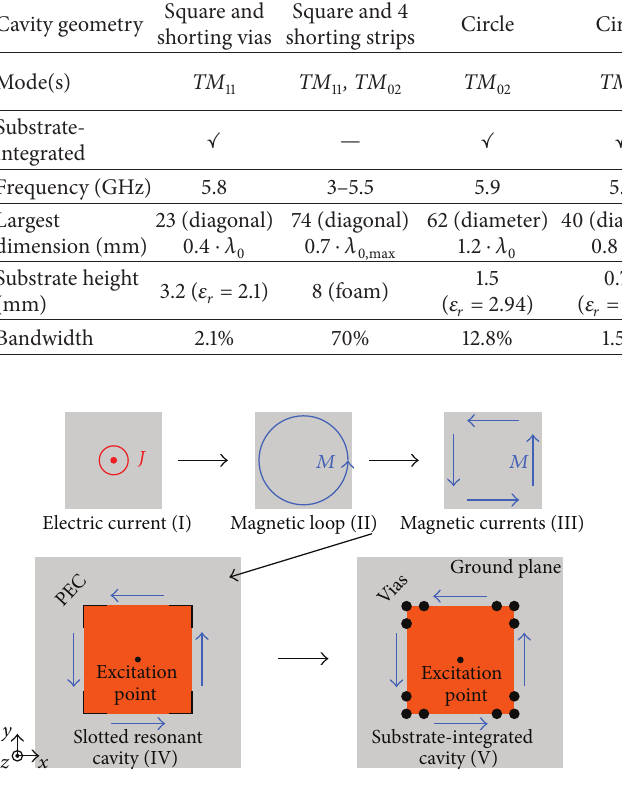
Figure 1: Radiation principle as an evolution from electric current perpendicular to a ground plane to a slotted substrate-integrated